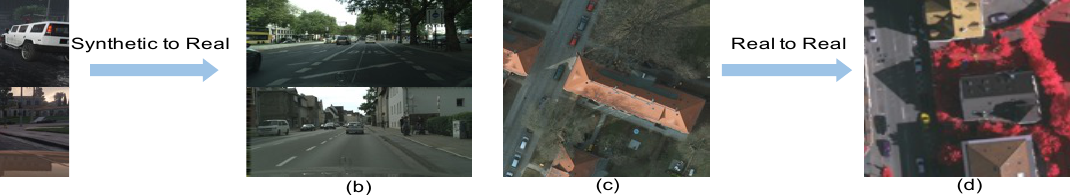
Figure 1. Synthetic-to-real and real-to-real translation. ( a ) GTA5. ( b ) Cityscapes. ( c ) PotsdamRGB. ( d ) Vaihingen. GTA5 is a commonly used computer-synthesized dataset; the typical task of UDA in the computer vision field is to train a model on GTA5 and deploy it on a natural world scene such as Cityscapes. As a comparison, the mission of UDA of RS images is always the real-world scene (e.g., Potsdam) to another real-world scene (e.g.,